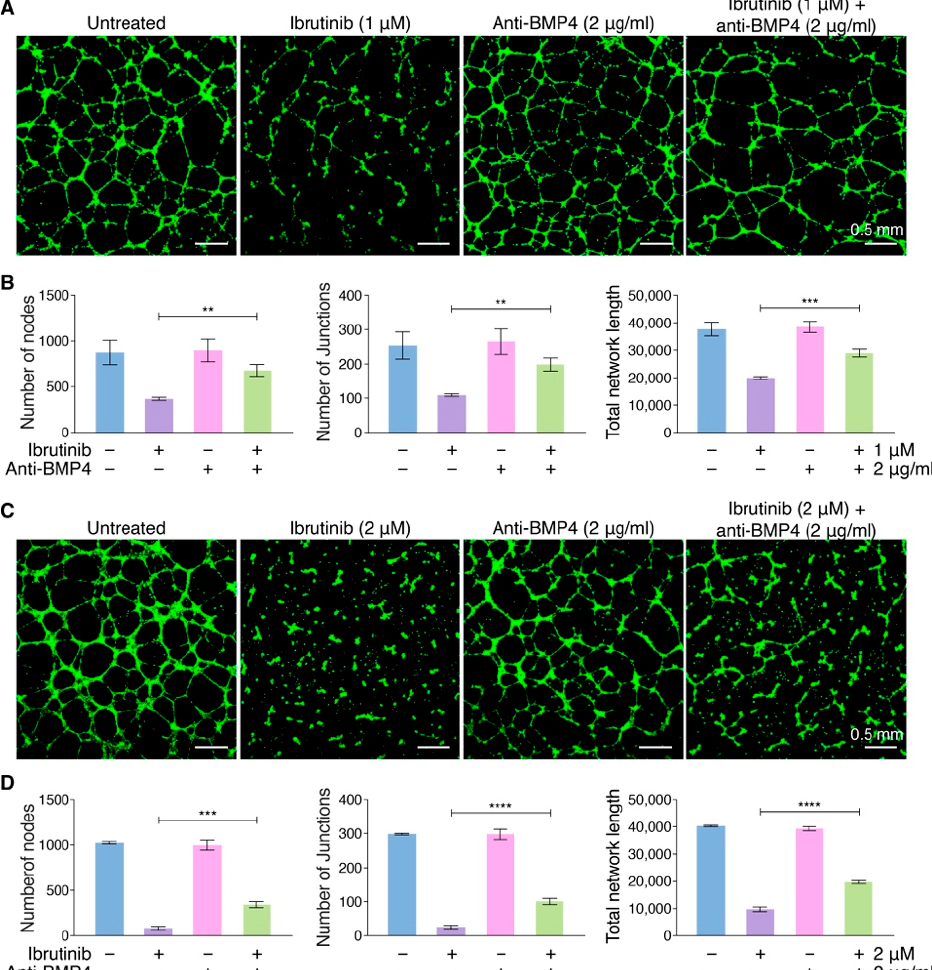
Figure 5. Anti-BMP4 mAb inhibits the capability of Ibrutinib to disrupt vascular dysfunction. ( A ) The net-like structure of endothelial cells on Matrigel under treatment with Ibrutinib (1 µ M) and/or anti-BMP4 mAb (2 µ g/mL), which was observed under fluorescence microscopy after staining with Calcein AM. Untreated endothelial cells were used as control. Scale bars, 0.5 mm. ( B ) The nodes, junctions and total network length of endothelial networks from ( A ) were quantified using the ImageJ software ( n = 5). Data are shown as mean ± SEM; ** p < 0.01; *** p < 0.001, as calculated using one-way ANOVA with Tukey’s multiple comparisons test. ( C ) The net-like structure of endothelial cells on Matrigel under treatment with Ibrutinib (2 µ M) and/or anti-BMP4 mAb (2 µ g/mL), which was observed under fluorescence microscopy after staining endothelial cells with Calcein AM. Untreated endothelial cells were used as control. Scale bars, 0.5 mm. ( D ) The nodes, junctions and total network length of endothelial networks from ( C ) was quantified using the ImageJ software ( n = 5). Data are shown as mean ± SEM; *** p < 0.001; **** p < 0.0001, as calculated using one-way ANOVA with Tukey’s multiple comparisons test.